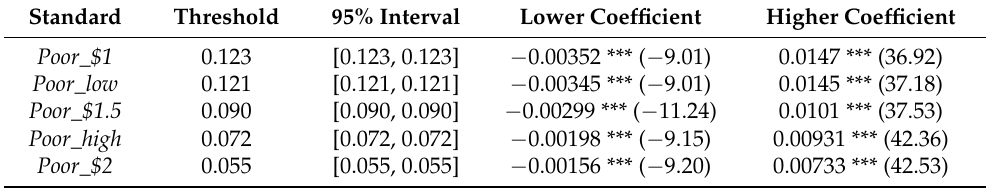
Table 21. Threshold estimates, confidence intervals, and coefficient